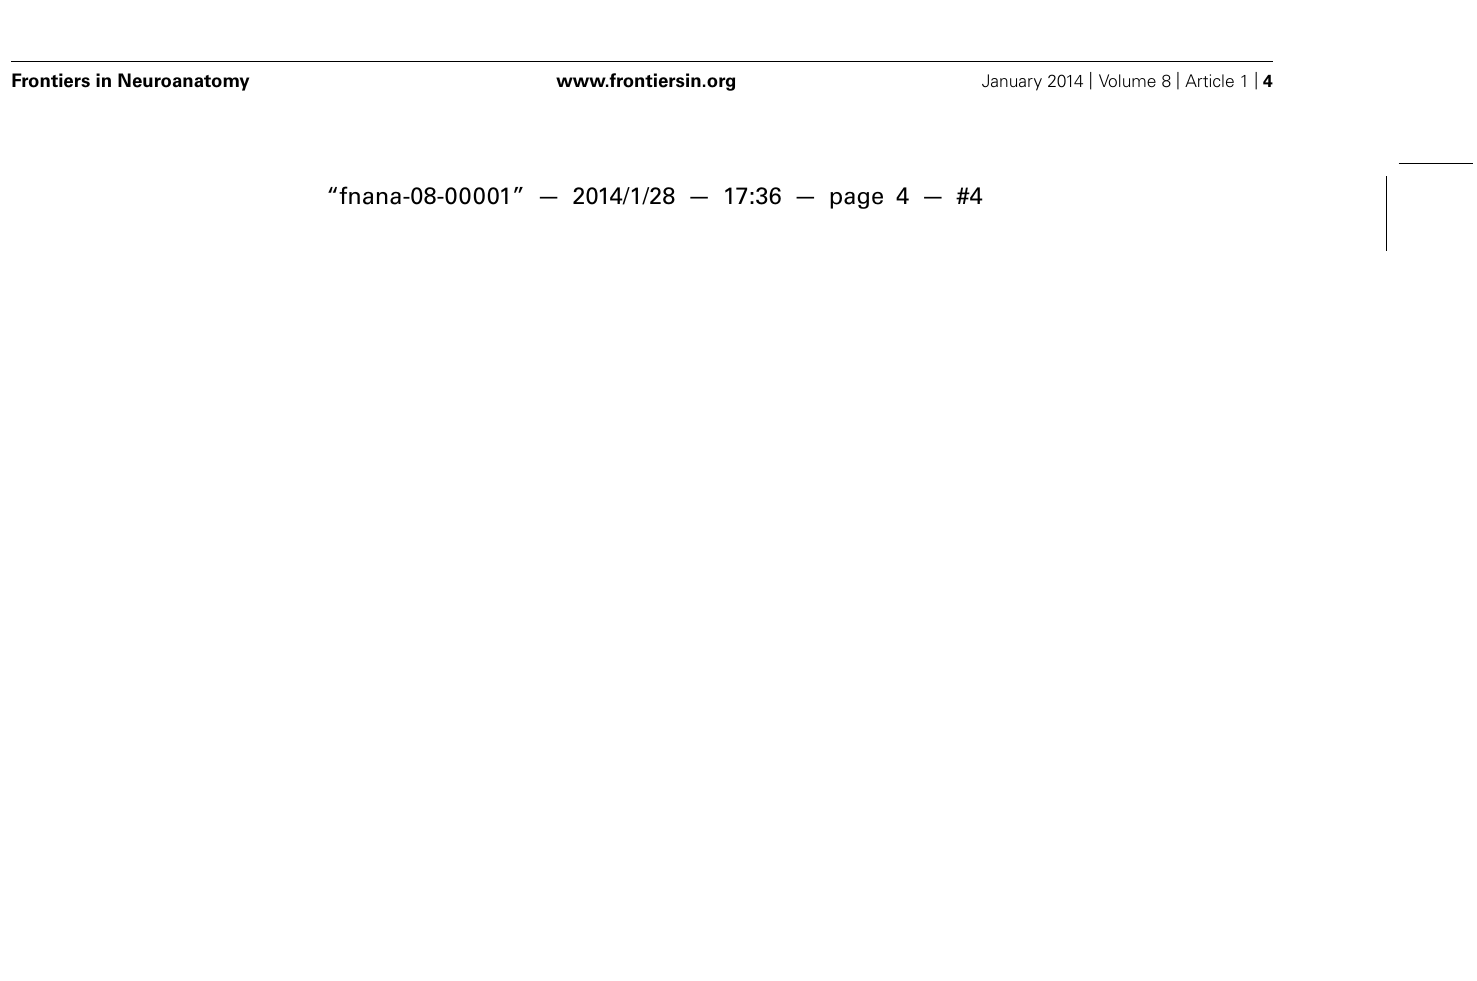
Gewebelehre des Menschen). Right: the first illustration of a histological preparation by Golgi with his silver nitrate method (“reazione nera”; black reaction) to study the olfactory bulb of the dog (Golgi, 1875). Taken from DeFelipe